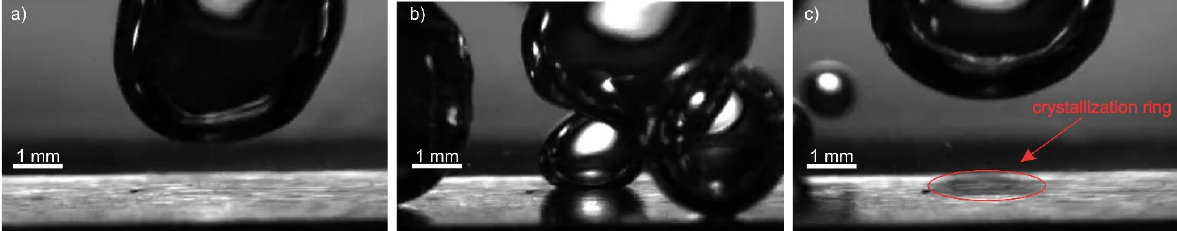
Figure 7. Boiling of a 2.0 g/L CaSO 4 solution on a thin stainless steel ribbon heater at ( a ) 2.033s ( b ) 2.5 s and ( c ) 2.967s.